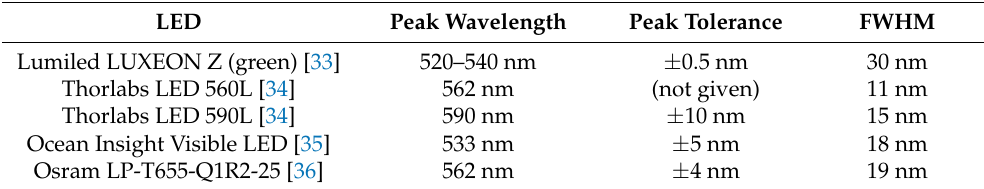
Table 2. Example visible band LEDs in the 520–600 nm range of interest. Spectral widths are provided as